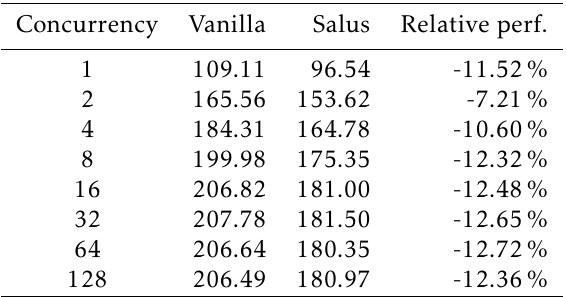
Table 3. Requests per second of an SSL-enabled webserver where every SSL session is protected in its own